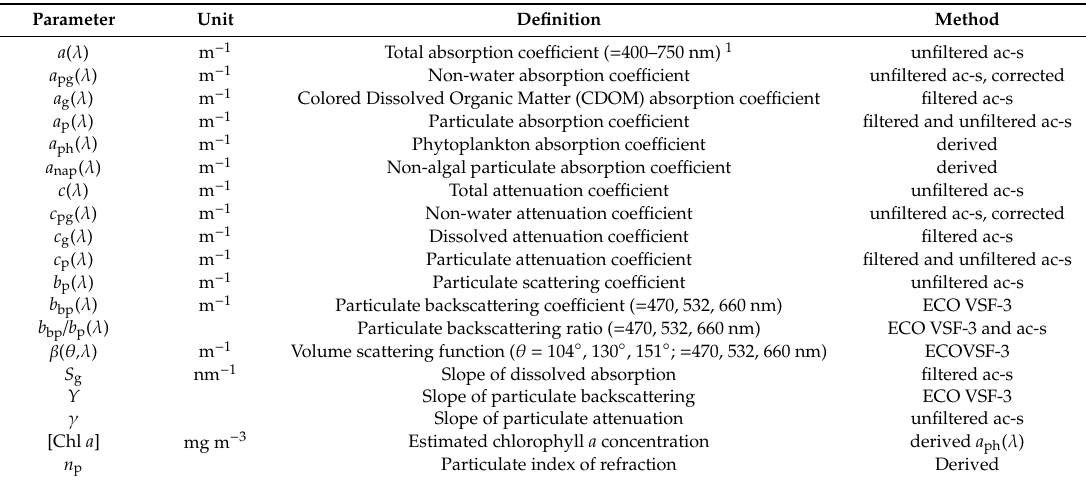
Table 1. Summary of measured and derived optical data for all stations in this